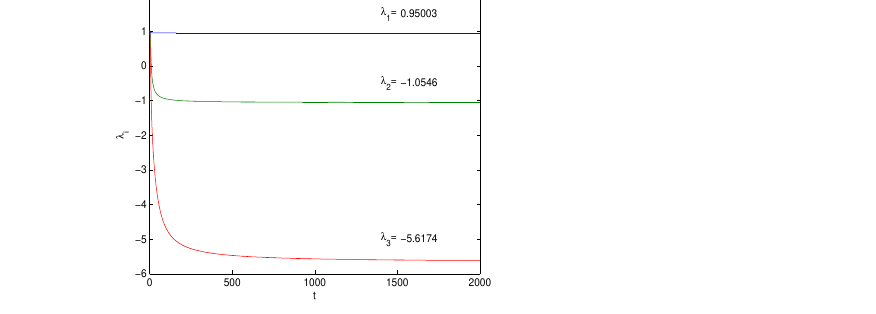
Figure 11. Lyapunov exponents of system (4) with parameters given in (18) and h = 0.1.